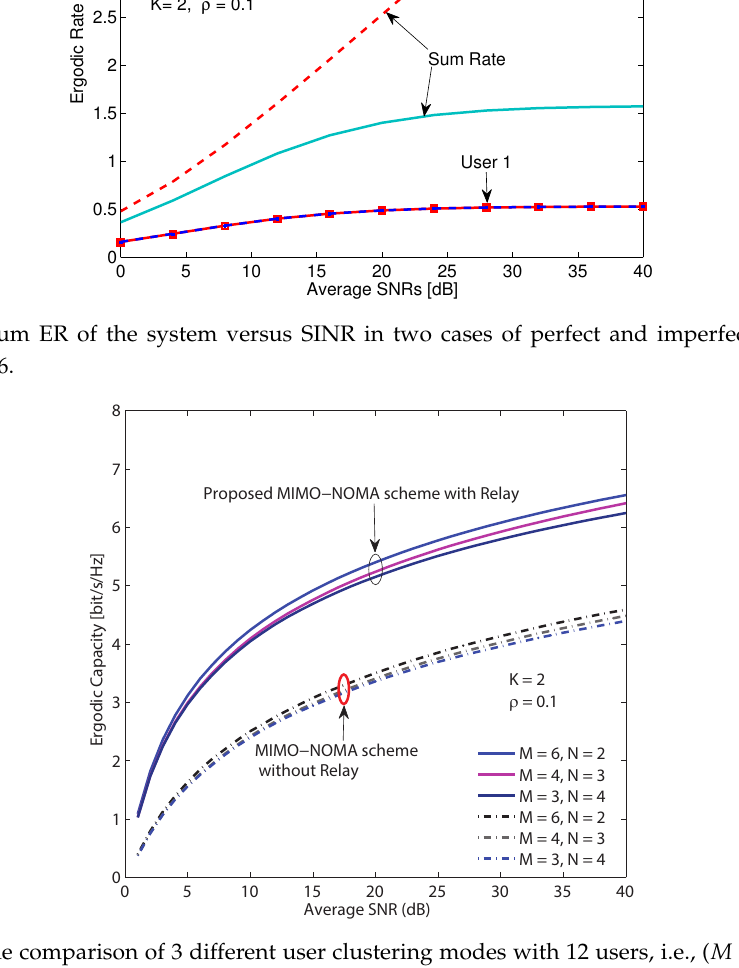
Figure 12. The comparison of 3 different user clustering modes with 12 users, i.e., ( M = 6, N = 2), ( M = 4, N = 3) and ( M = 3, N = 4), and ξ 1 = ξ 2 =